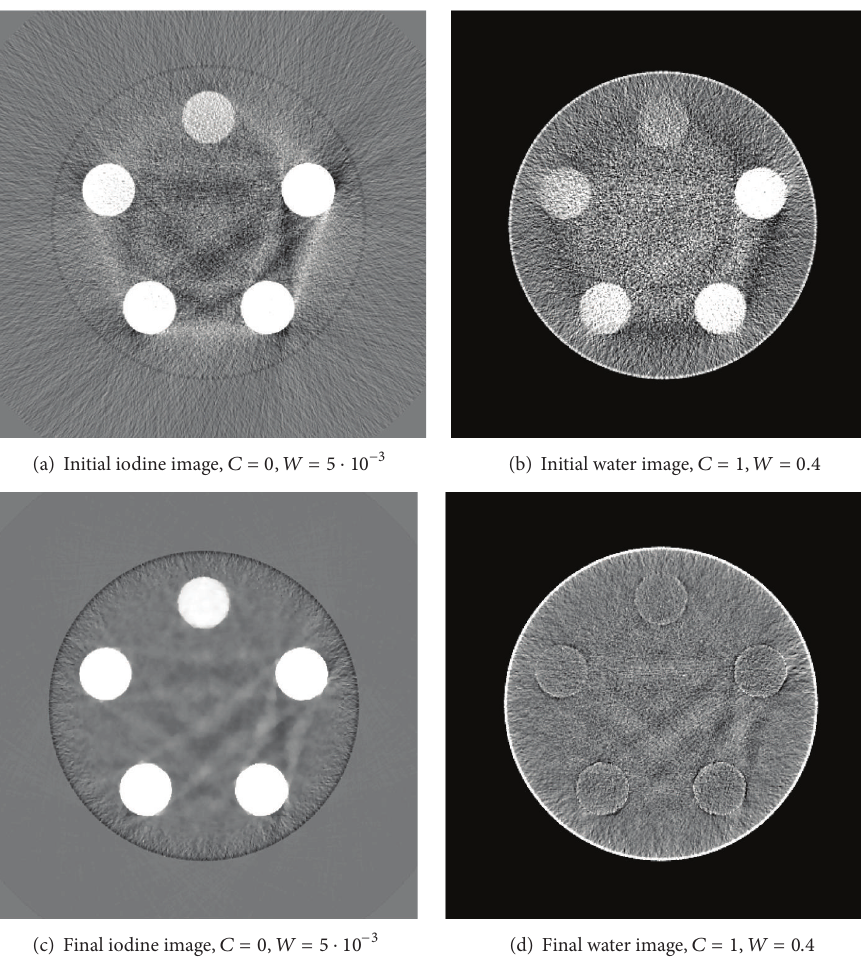
Figure 5: Initial ((a), (b)) and final ((c), (d)) material images from data set of a realistic PCD with the proposed algorithm after 1000 iterations. The selected regularization parameters were 𝛾 iodine = 8.6 ⋅ 10 −5 , 𝛾 H 2 O = 1.4 ⋅ 10 −2 , and 𝜂 ∗ ⋅ 𝛾 ∗ = 1 ⋅ 10 −5